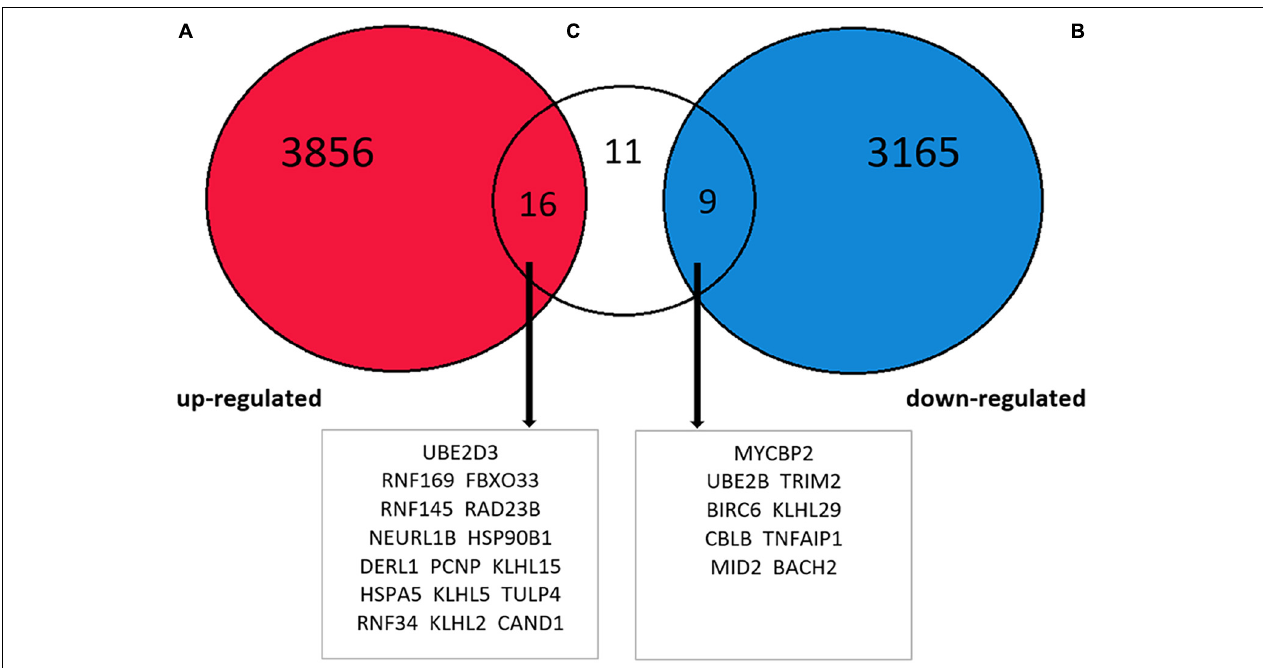
FIGURE 7 | Intersection between EMBL-EBI website METH processing animal brain tissue RNA high-throughput sequencing data analysis results and 36 target genes. The increased expression of 16 target genes, decreased expression of 9 target genes, and 11 target genes without any